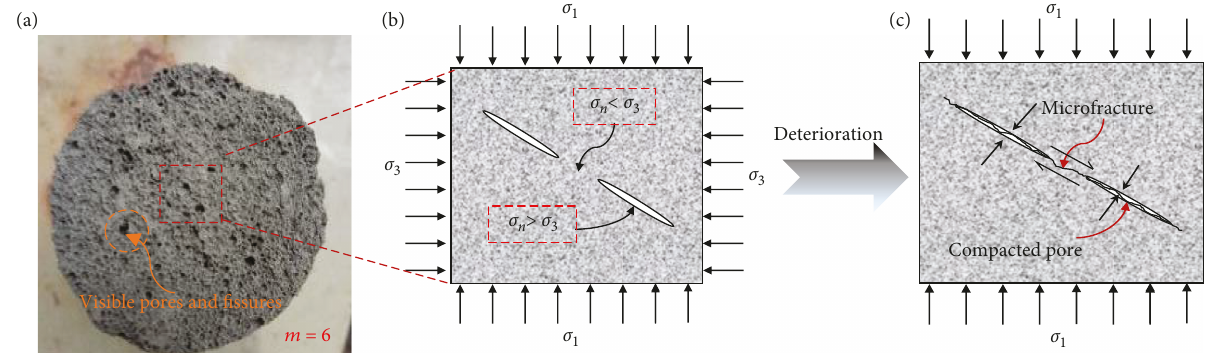
Figure 12: Microfracture propagation in a soft coal mass due to a macrofailure process. (a) Fracture diagram of the coal mass specimen ( m = 6 ). (b) Three-dimensional stress stability structure of the coal mass. (c) The microfracture develops into a macroscopic fi